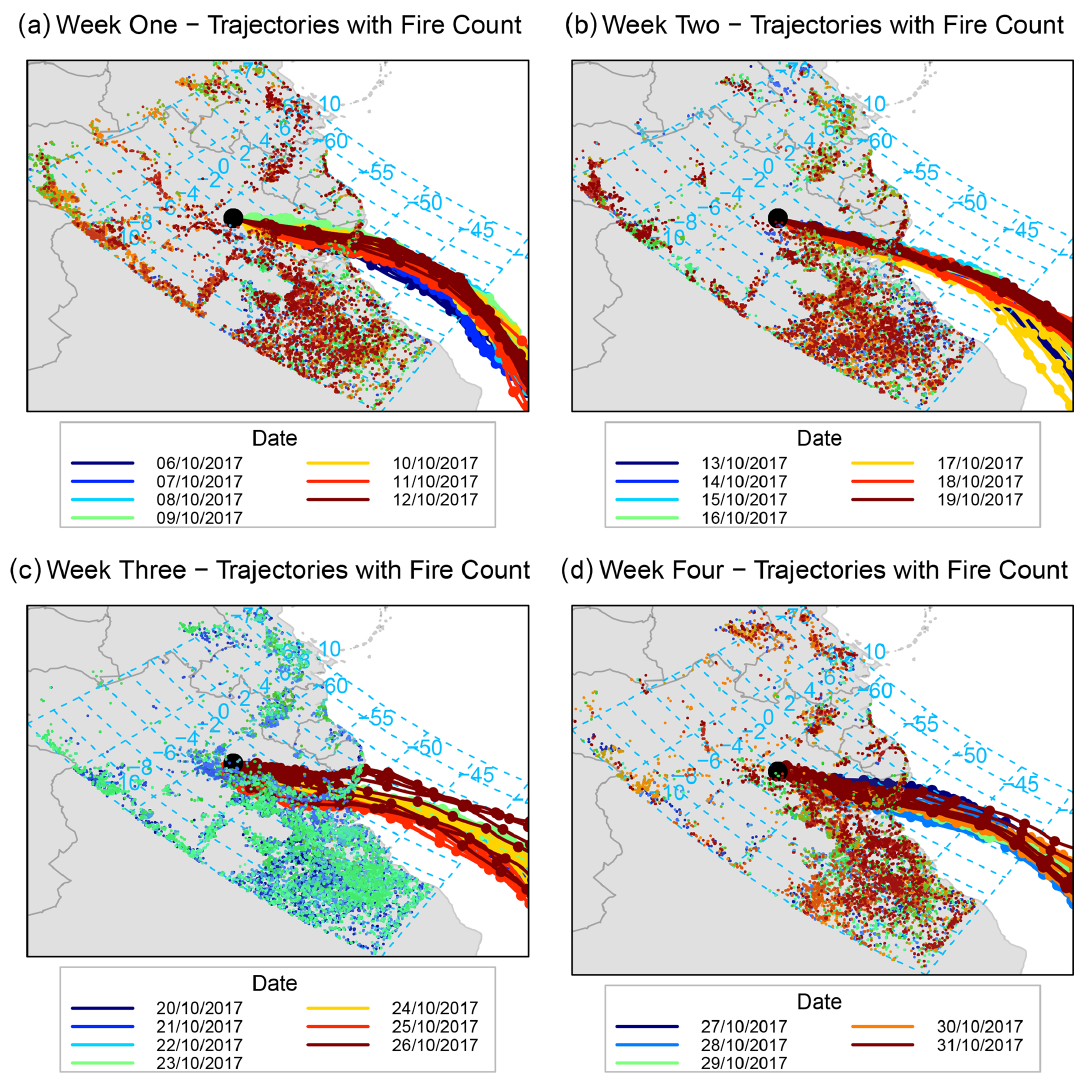
Figure A1. Air-mass back-trajectories arriving at the 80m walk-up tower on each day every 3h from 00:00 local time over the period from 6 October 2017 to 31 October 2017, grouped by week, and further subdivided by day, for the regional area surrounding the ATTO site. Fire count data are included as an overlay to each weekly plot, with fire count coloured according to the date on which the fire was recorded by satellite